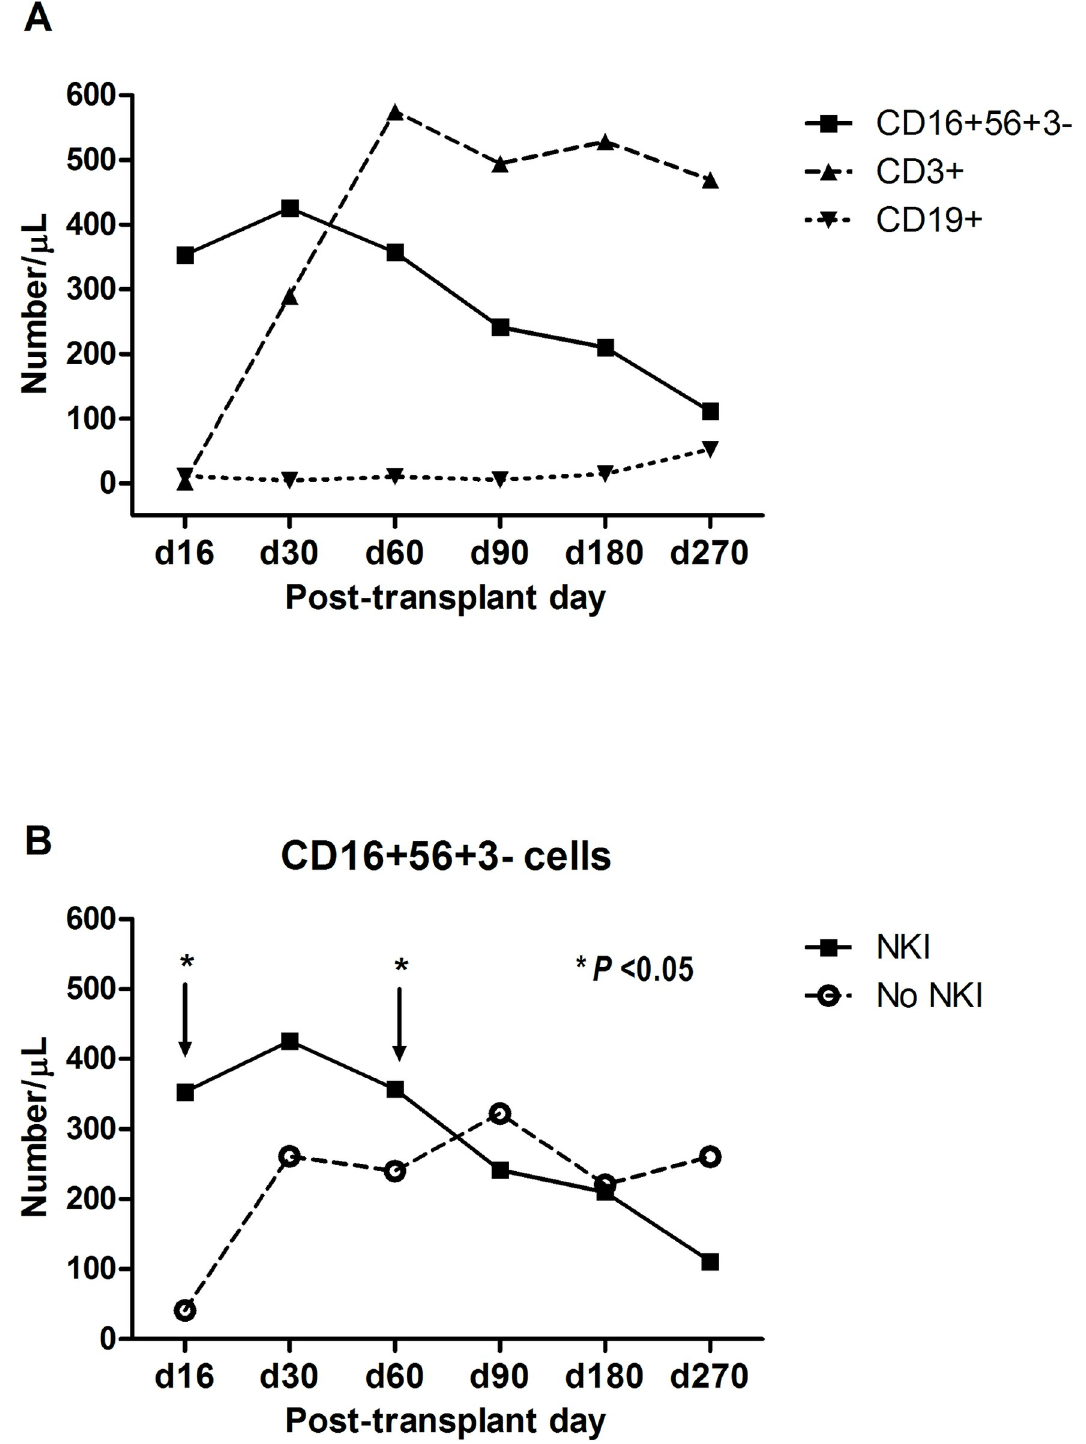
Fig 2. Immune reconstitution after NKI following haplo-SCT. ( A) Immune reconstitution after NKI following haplo-SCT in six patients who completed three scheduled NKIs. Median values for cell numbers are presented. (B) The number of NK cells was higher until day 60 in the study cohort compared to the reference cohort, who underwent haplo-SCT without NKI.